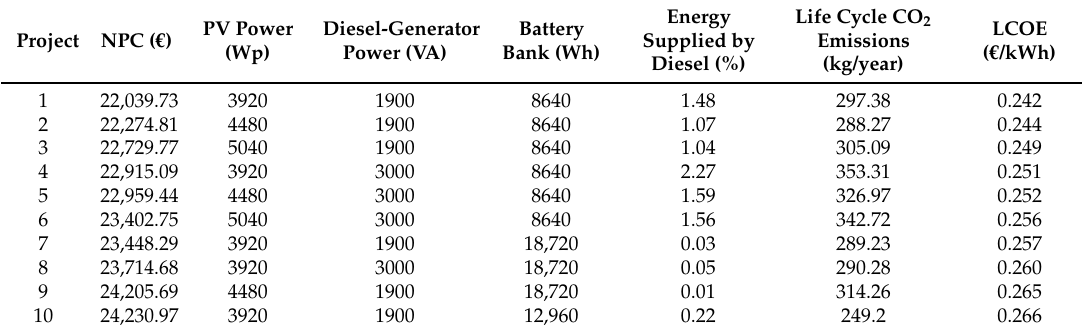
Table 4. Main results of the best combinations given by iHOGA solar PV + Diesel + Batteries. PV Power Project NPC ( € )